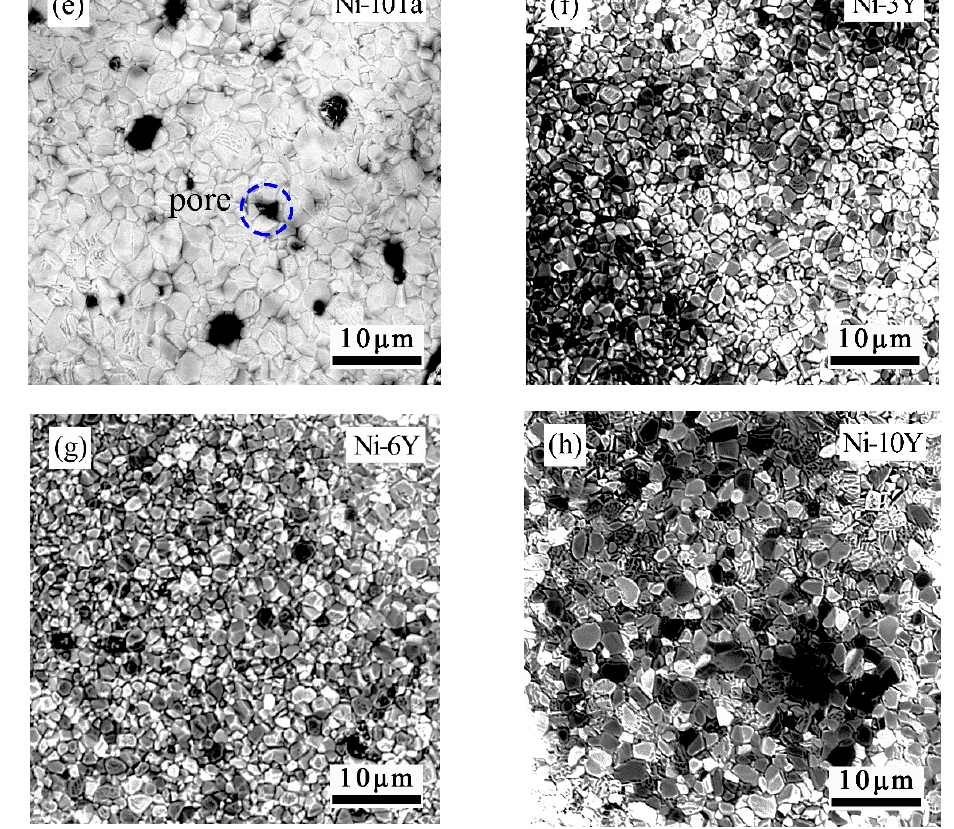
Figure 6. SEM micrograph of surface of samples oxidized at 800 ◦ C for 200 h: ( a ) pure Ni, ( b , c ) Ni-3Ta, ( d , e ) Ni-(6~10) Ta, ( f – h ) Ni-(6~10) Y.